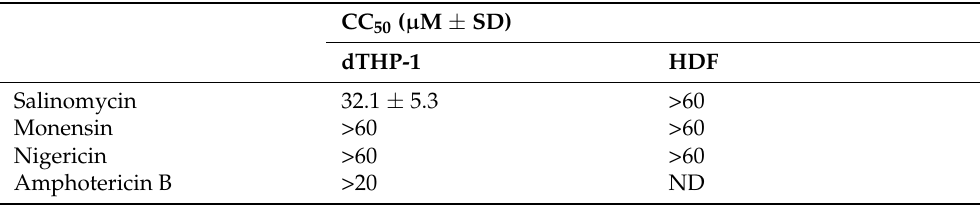
Table 2. Cytotoxicity of salinomycin, monensin, and nigericin to dTHP-1 and HDF.